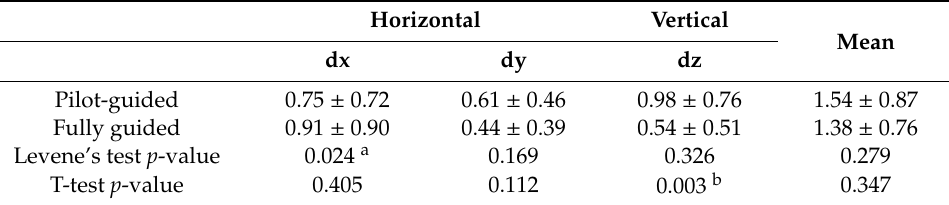
Table 3. Deviations—apical